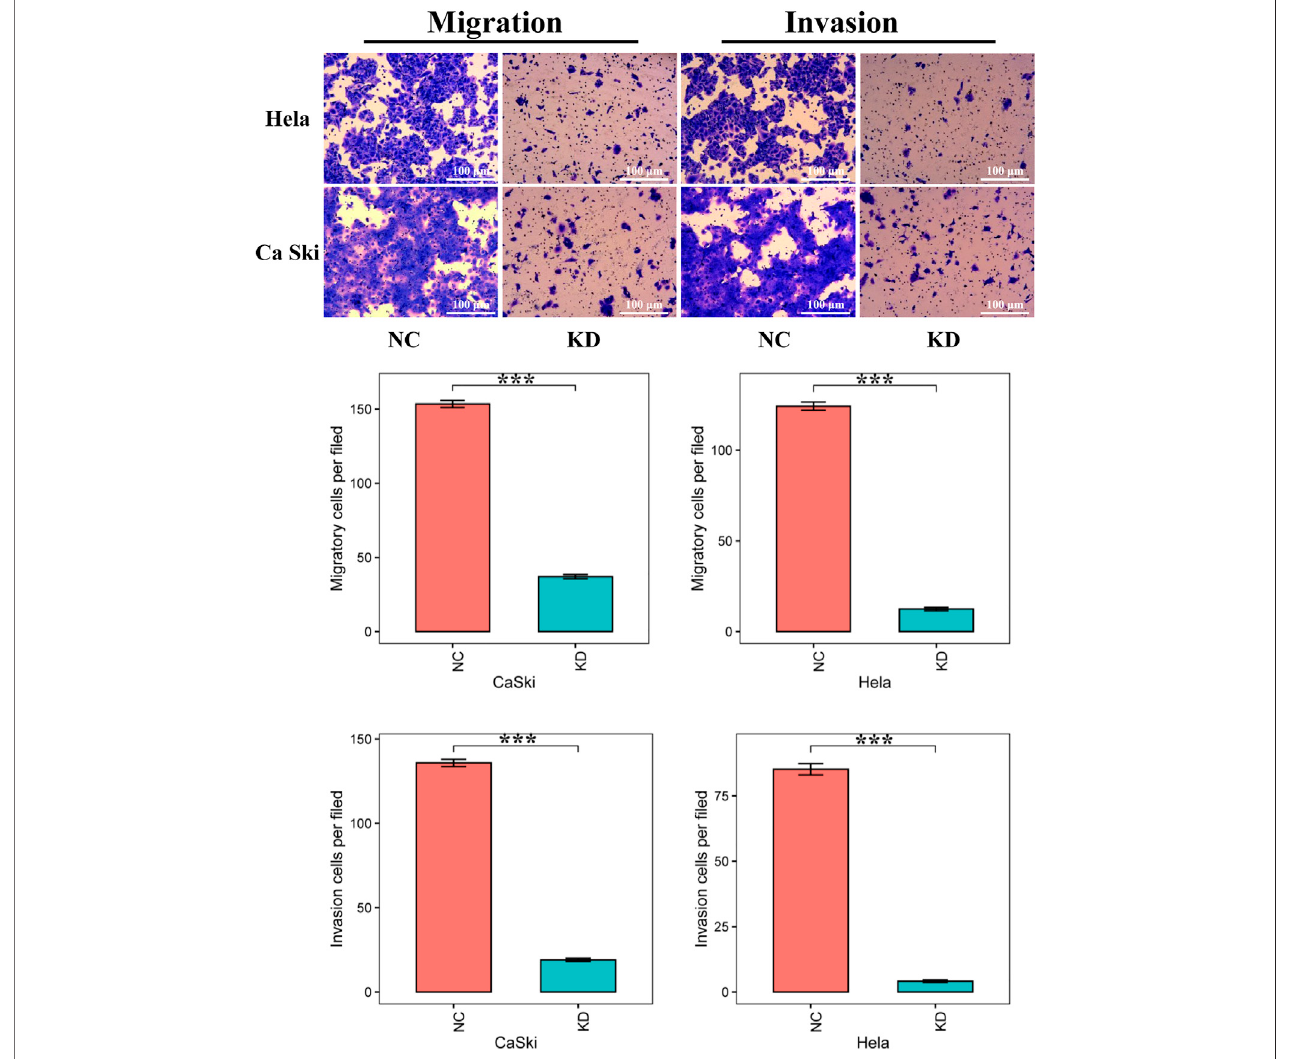
FIGURE 9 | Down-regulation of ATG5 signi fi cantly decelerates cervical cancer cells migration and invasion. Magni fi cation × 100. Error bars represent ± SD. *** p < 0.001.